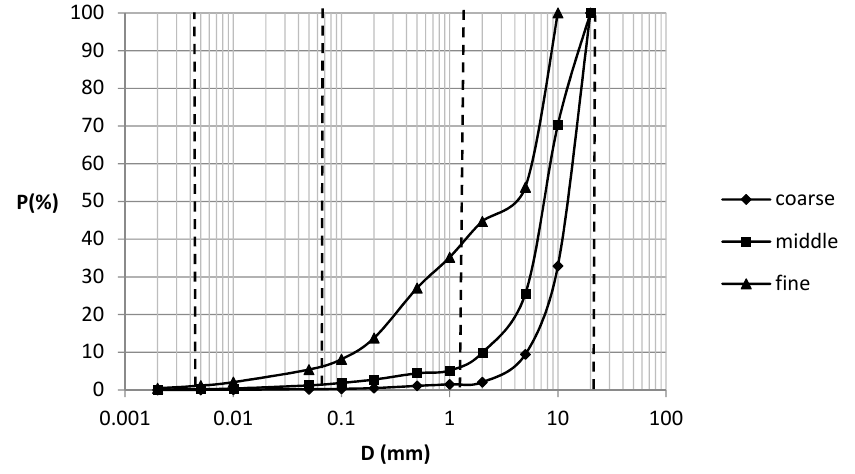
Figure 2. Cumulative grain size distribution of the three bed materials used in the flume tests.